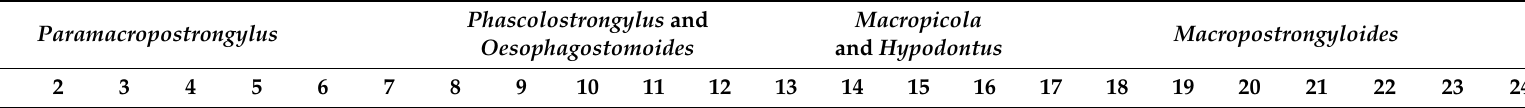
Table 3. Pairwise distances (%) within the concatenated first and second internal transcribed spacer (ITS+) among the Phascolostrongylinae nematode species included in the phyloge- netic